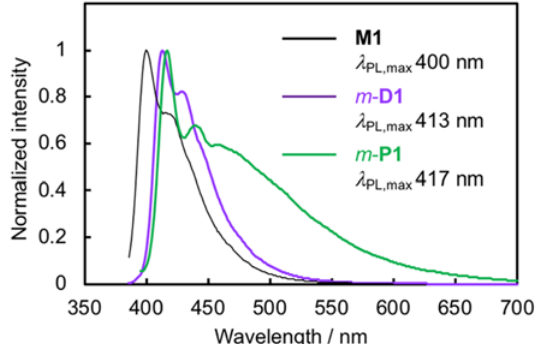
Figure 4. PL spectra of M1 , m - D1 , and the soluble part of m - P1 in CHCl 3 (1.0 × 10 –5 M for M1 and m - D1 , and 0.84 × 10 –5 M for m - P1 ), excited at each λ abs,max .